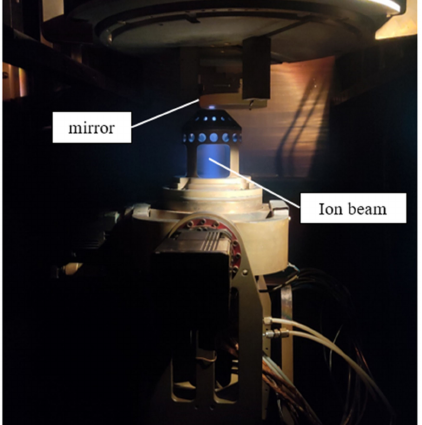
Figure 20. The practical processing setup using the 10 mm diameter beam.